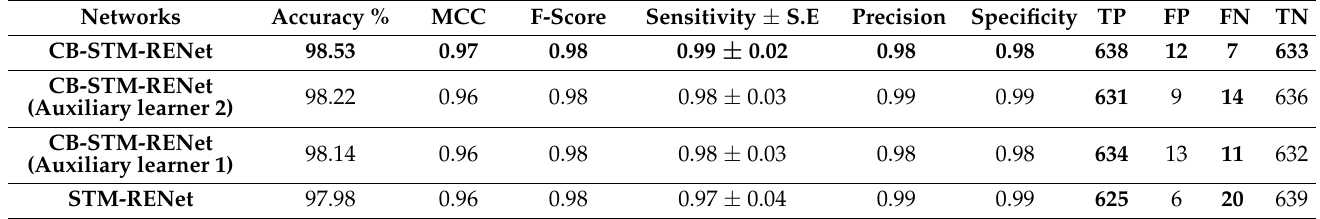
Table 2. Ablation study for the proposed deep CNN models on CoV-Healthy-6k